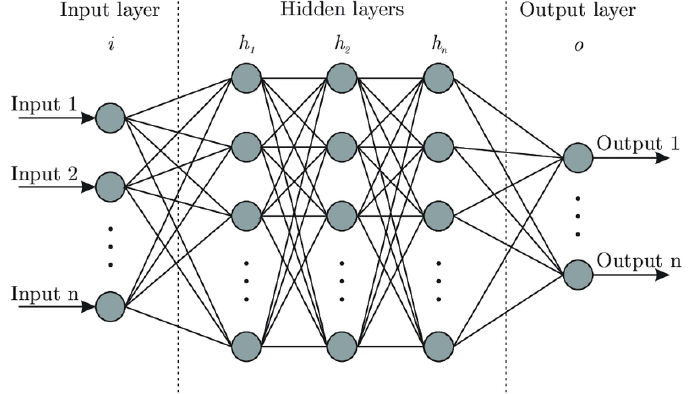
Figure 4. Artificial neural network typical architecture.